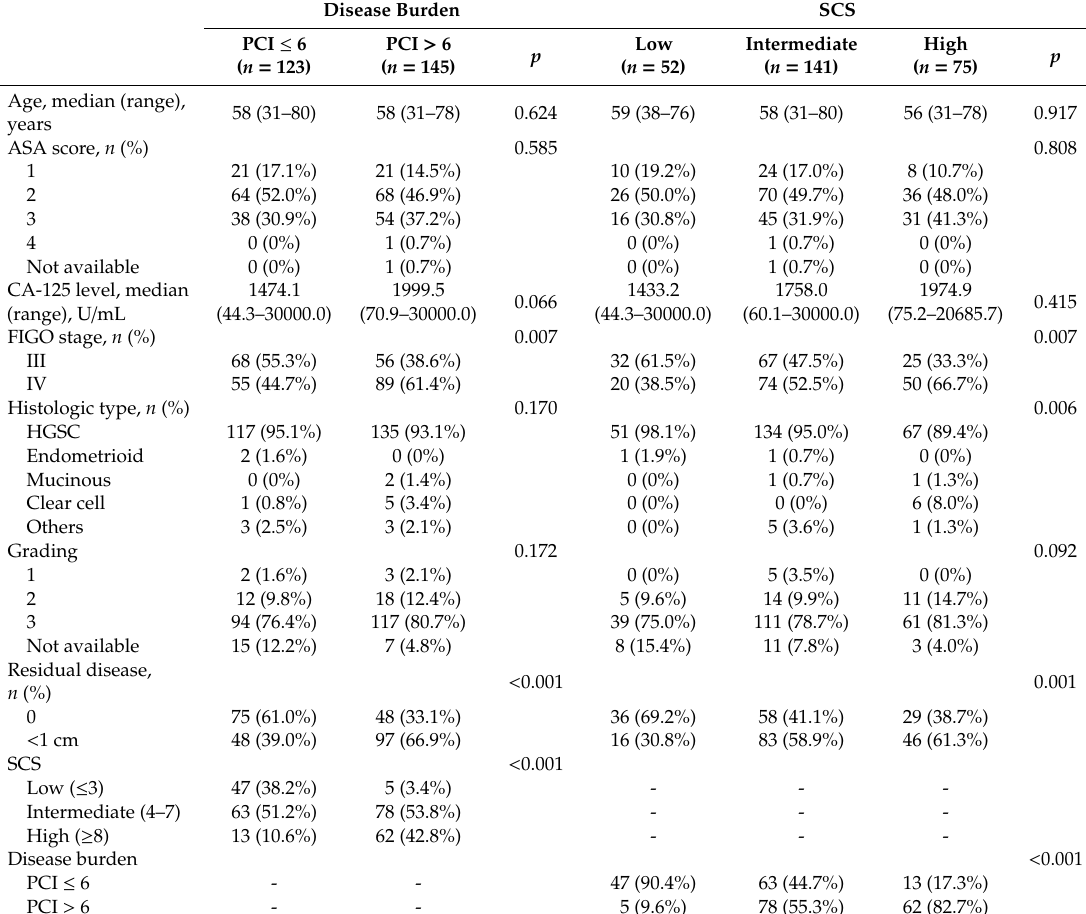
Table 1. Patient characteristics by disease burden after neoadjuvant chemotherapy (NAC) and surgical complexity score